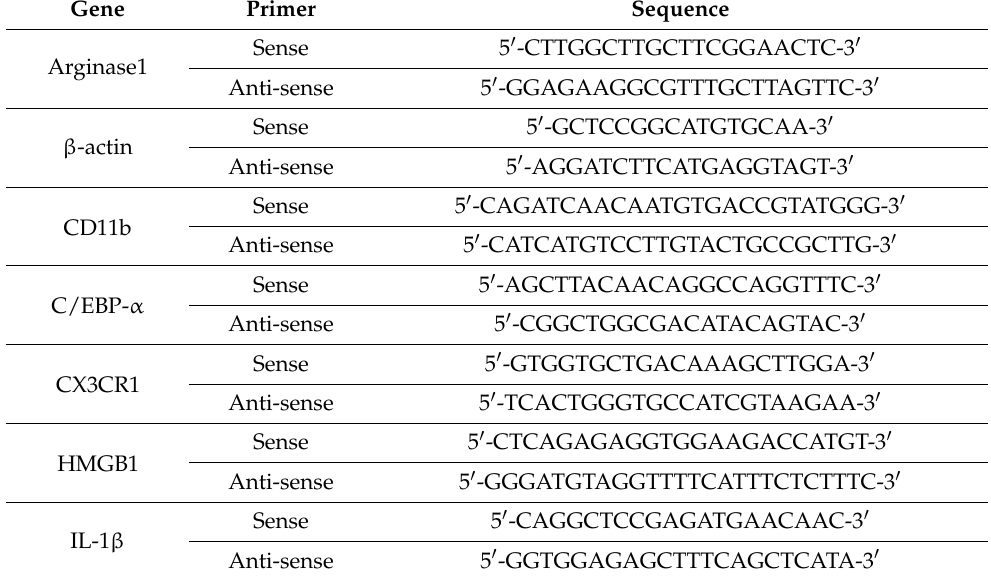
Table 1. List of pairs of primers used to determine gene expression by RT-qPCR assays.